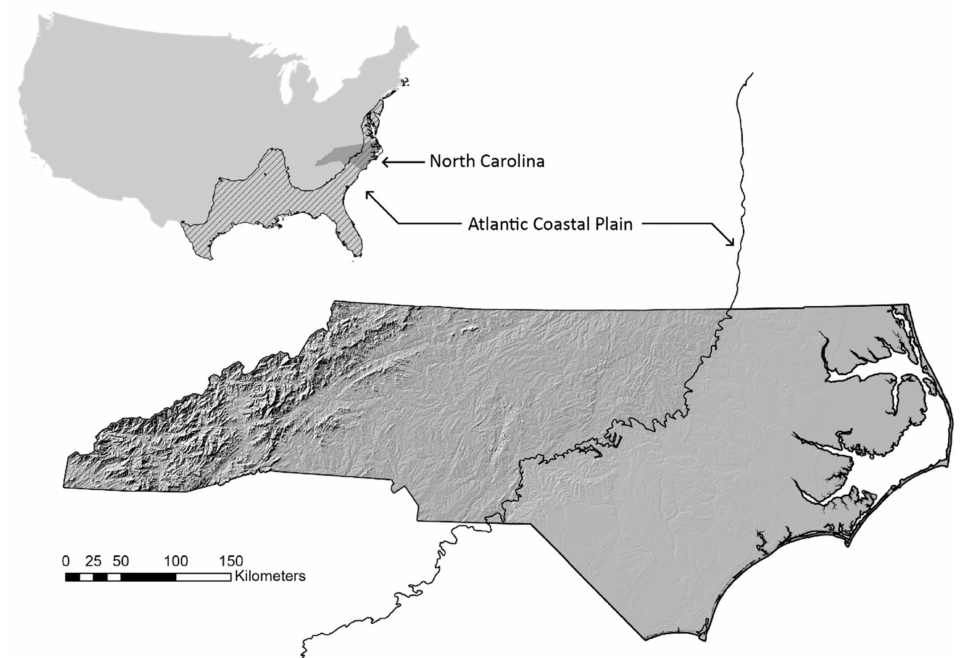
Figure 1. Location of Atlantic Coastal Plain within the United States with an enlargement showing location of Atlantic Coastal Plain within North Carolina. Within North Carolina, areas located east of the Coastal Plain are frequently referred to as ‘Eastern North